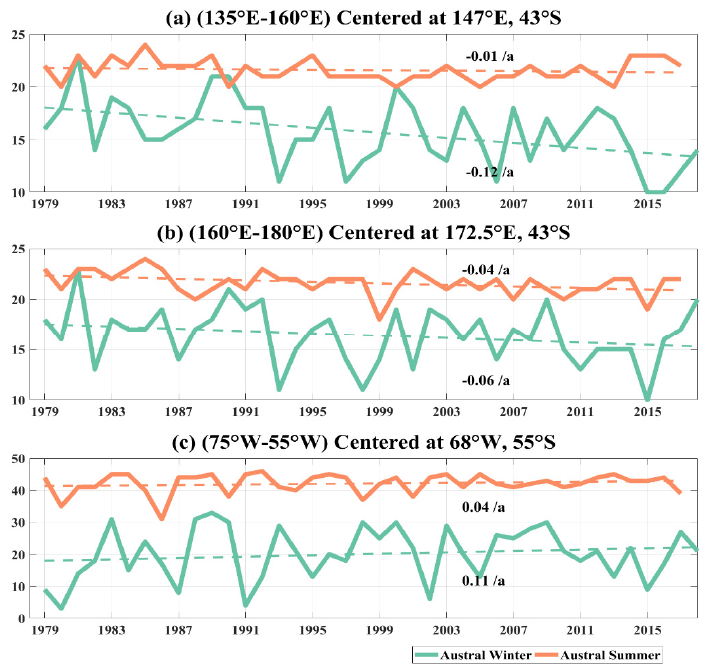
Figure 7. Sum and trend of the time windows for crossing the westerlies from three ports: (a) Hobart, (b) Christchurch, and (c) Ushuaia. ( b ) Christchurch, and ( c )